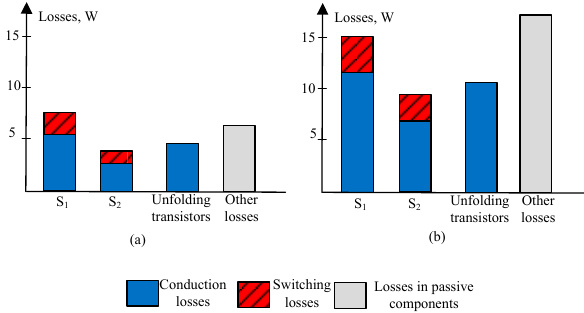
Figure 16. Losses distribution for 550 W at 250 V input voltage ( a ) and 1150 W at 350 V ( b ) input voltage.